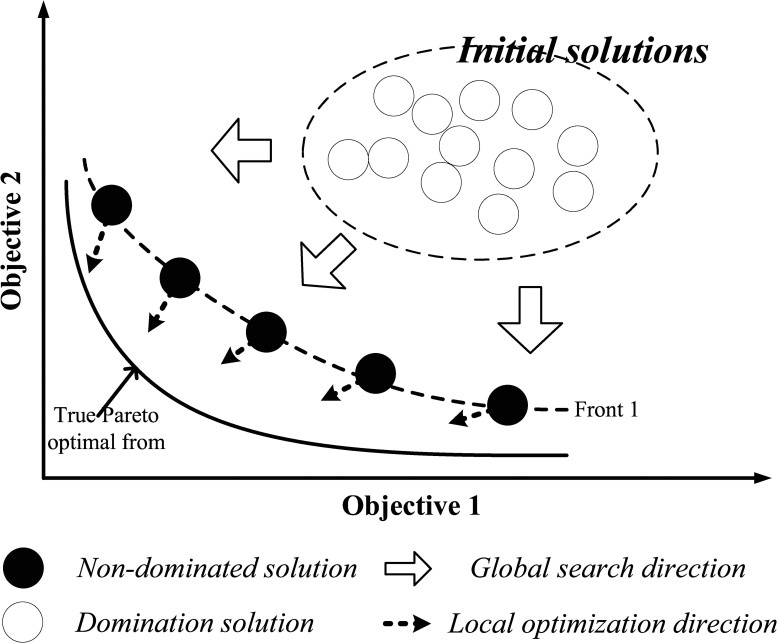
Sketch of multi-objective optimization [26].